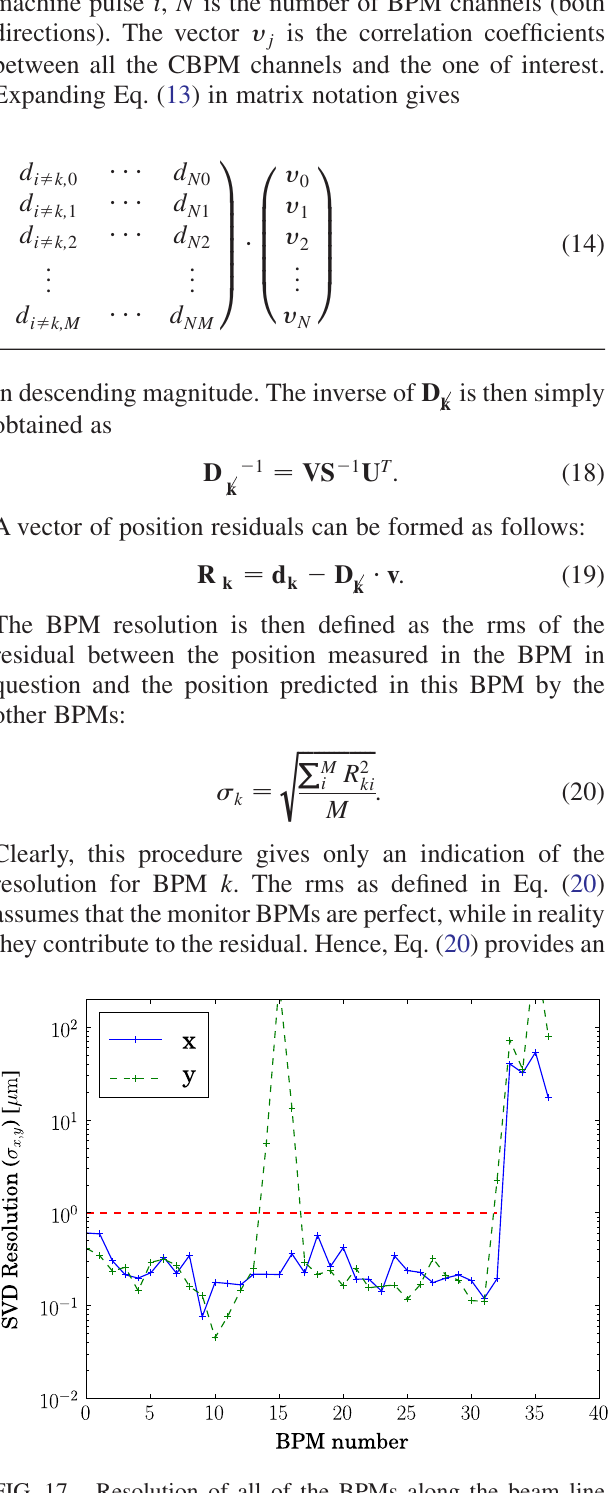
FIG. 17. Resolution of all of the BPMs along the beam line using data from April